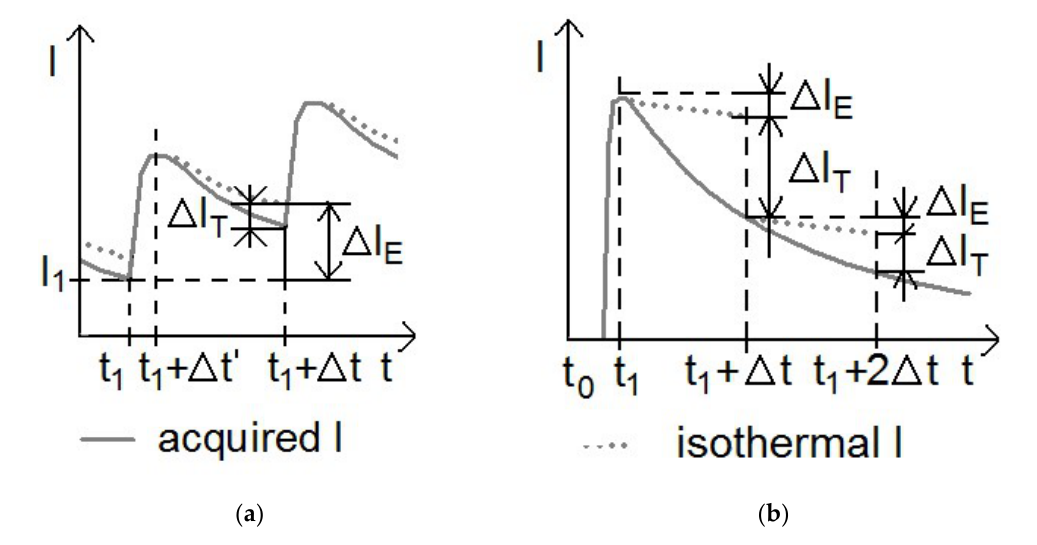
Figure 1. Current time response I for ( a ) stepping V n and ( b ) V n pulse.